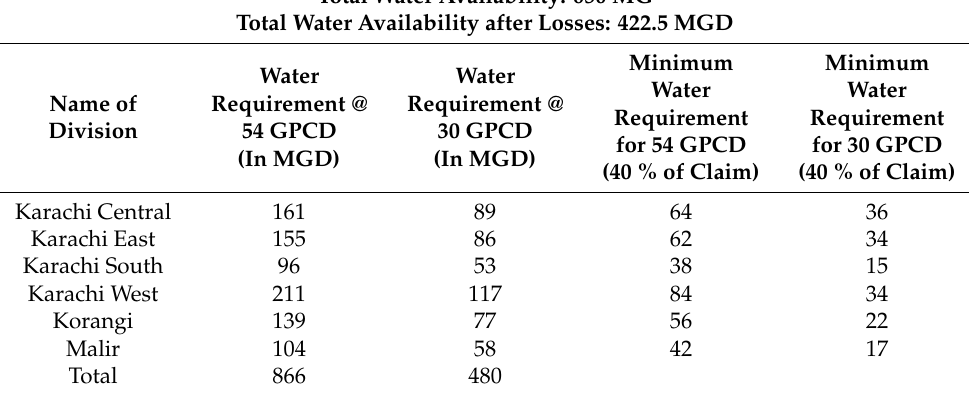
Table 5. Minimum water requirements for all